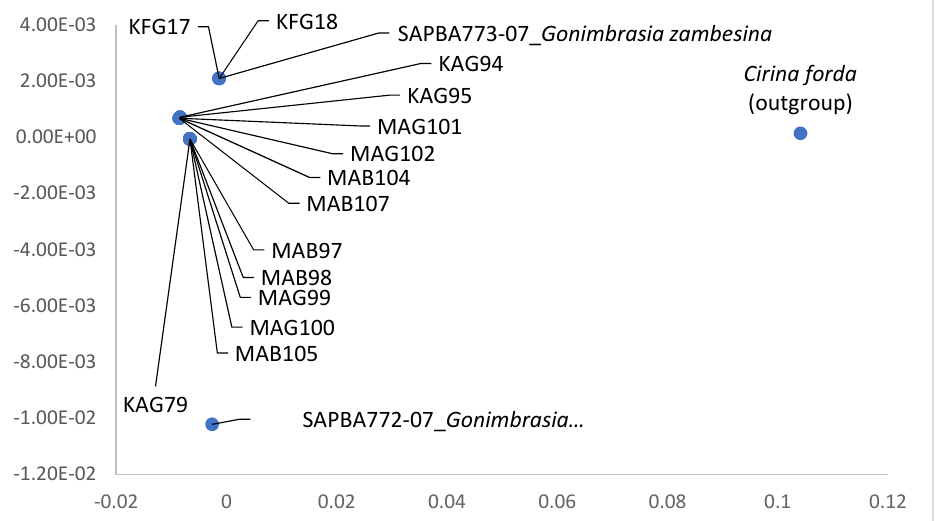
Figure 4. Principle coordinate analysis of COI gene of different morphotypes of Gonimbrasia zambesina from different locations in Kenya. The first two letters indicate the collection sites (MA = Makuyu, KA = Kambiti, and KF = Kilifi). The last letter indicates the color of the adult moth (G = green and B = brown). The number indicates sample ID. SAPBA772-07 and SAPBA773-07 are BOLD reference accession numbers in BOLD BIN cluster